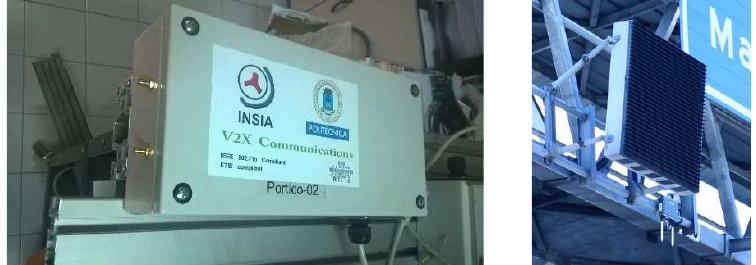
Figure 2. Relay RSU ( left ) and installation of Sending RSU on a variable message panel ( right ).